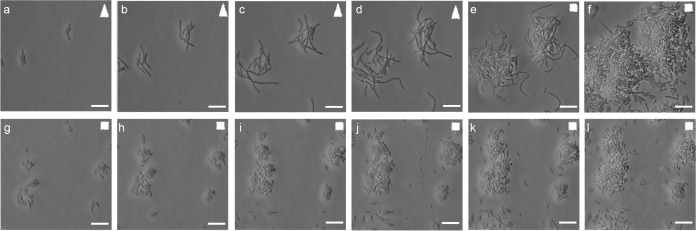
Overexpression of damX induces reversible UTI89 filamentation. Time-lapse images of strain UTI89/pSKdamX seeded on glass slides subjected to a flow of medium supplemented with 0.2% arabinose (white triangles) shown (a to d) or 0.4% glucose (white squares) (e and f), sequentially. (g to l) A negative control in which strain UTI89/pSKdamX was only subjected to 0.4% glucose (white squares) mediated damX repression. Addition of 0.2% arabinose (white triangles) allowed damX overexpression and filamentation therein, as seen in panels a to d. This filamentation phenotype was lost when damX induction was turned off, as seen in panels e, f, and g to l. Images were collected at 20-min intervals. Scale bars, 20 µm.